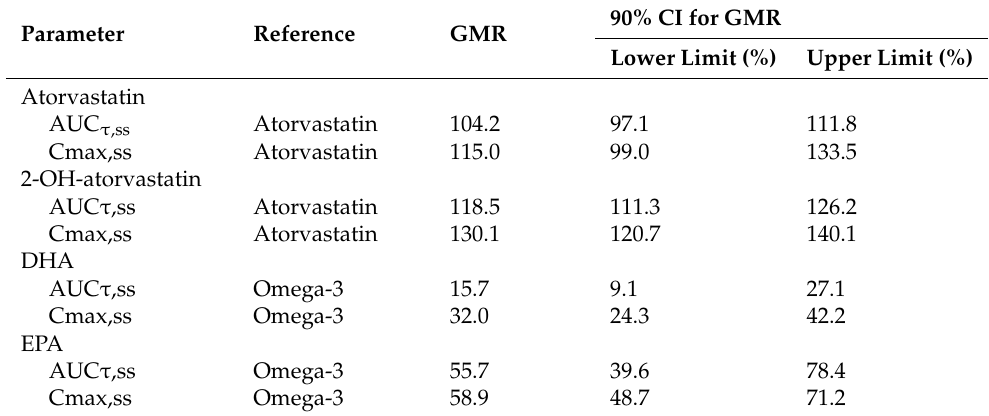
Table 3. Comparison of the pharmacokinetic parameters of atorvastatin, 2-OH-atorvastatin, DHA, and EPA between single drug administration and